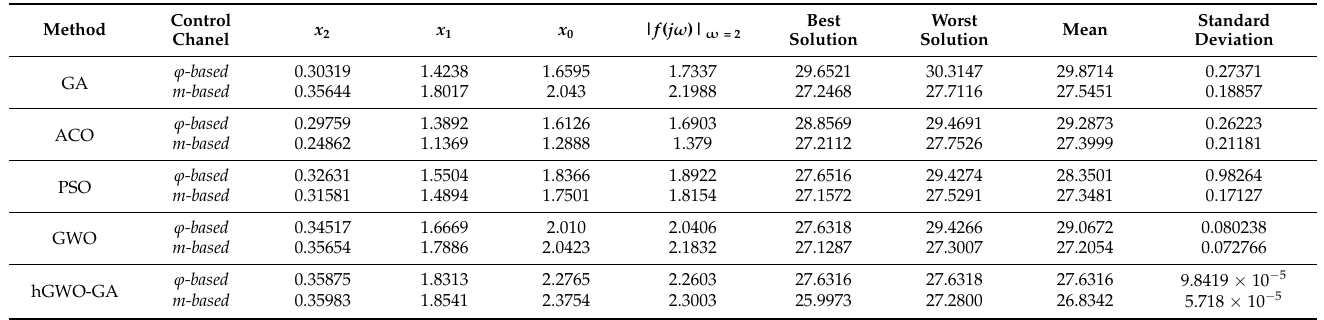
Table 8. Parameters of robust SSSC-based stabilizer ( F 2 and F 3).